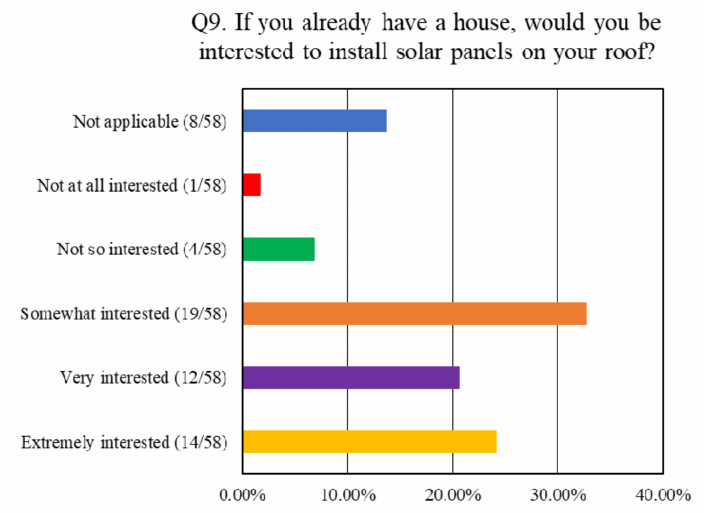
Figure 10. Participants’ interest in installation of solar panels on their